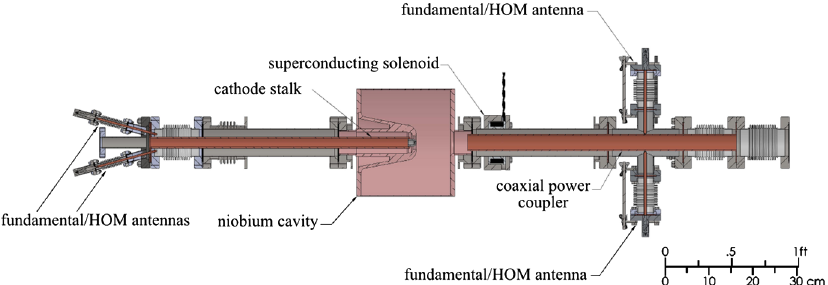
FIG. 7. Cathode stalk, cavity, and power coupler. The cathode stalk shown here was an earlier design before discontinuities were introduced to reduce rf power flow.